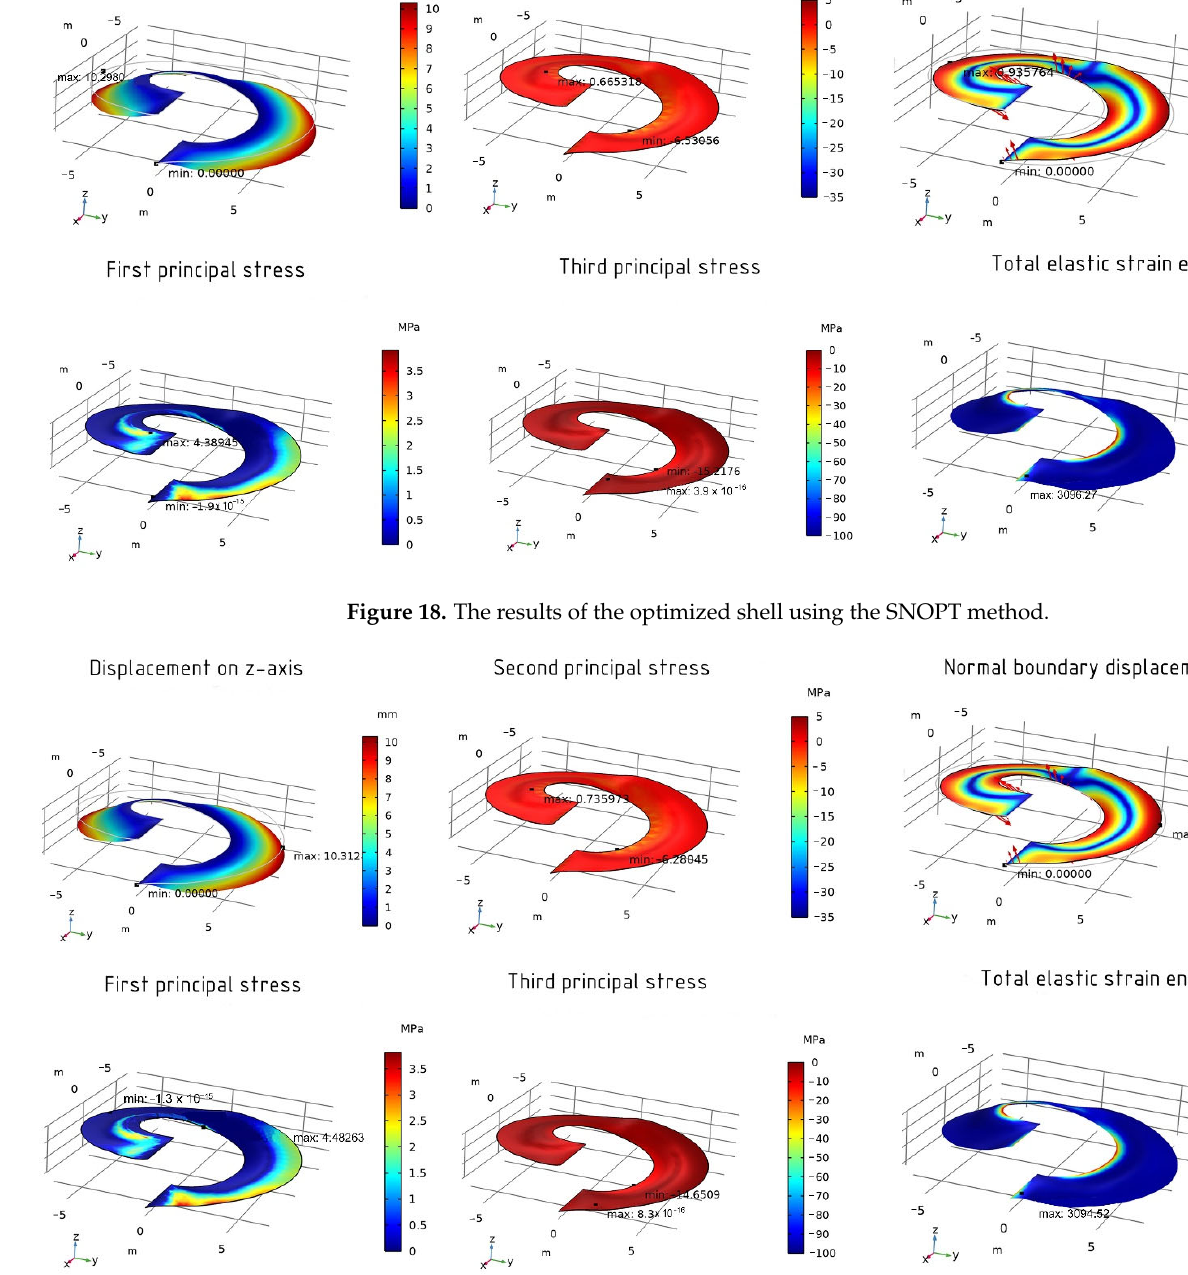
Figure 19. The results of the optimized shell using the IPOPT method. Table 3. Computational times for the three